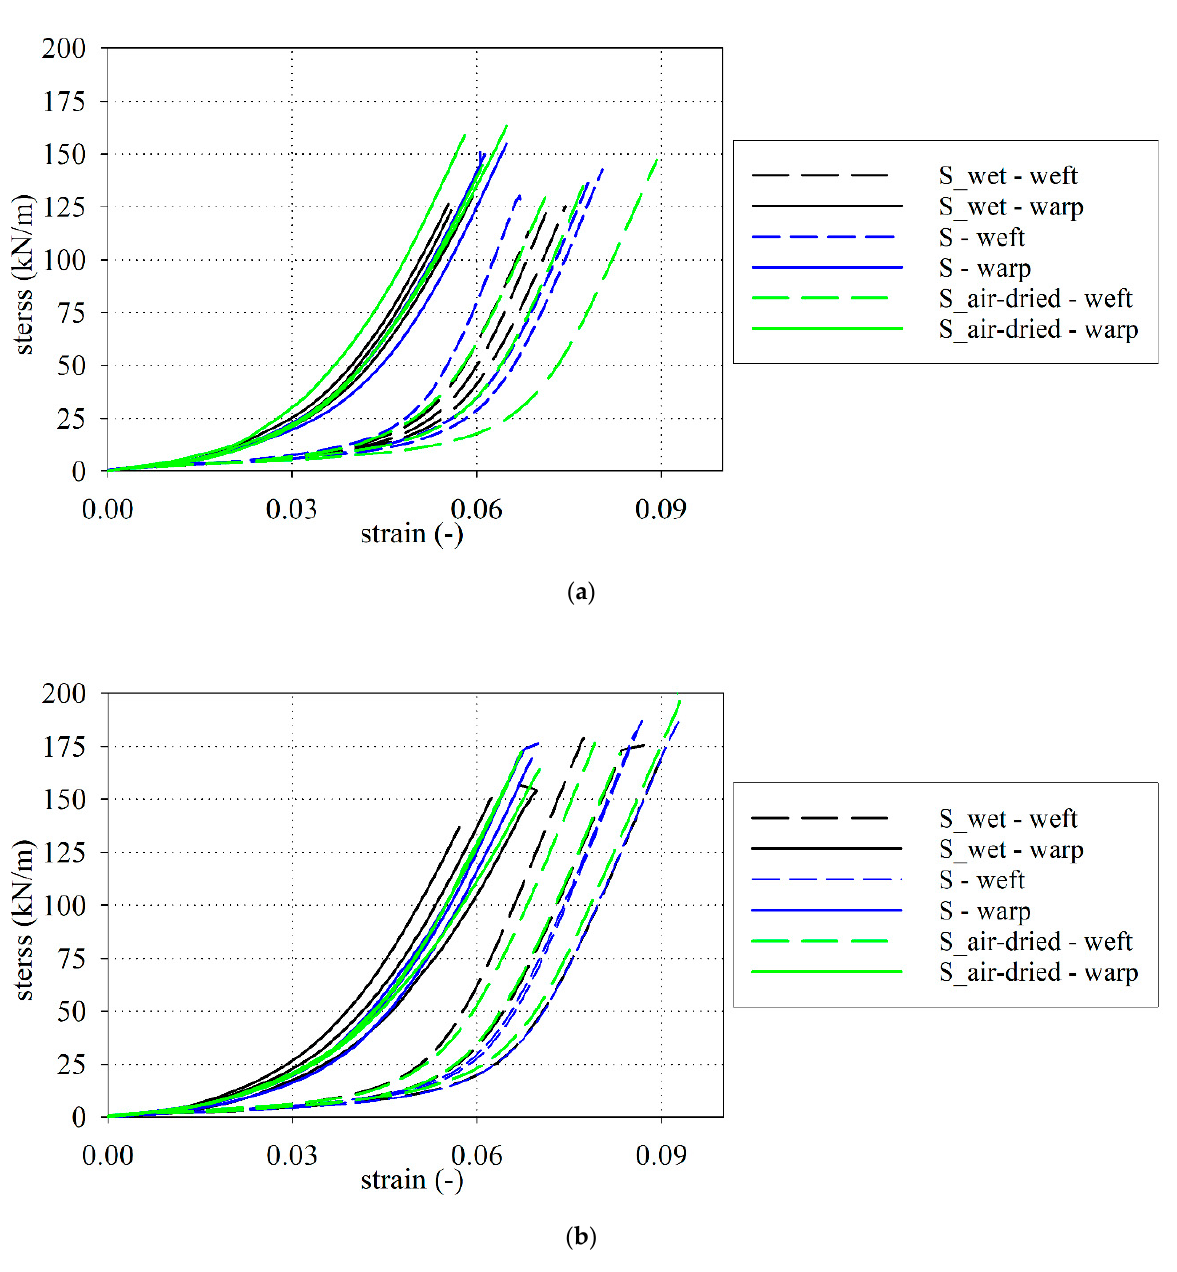
Figure 3. Stress-strain curves, S type fabric: ( a ) flat grips; ( b ) curved grips.